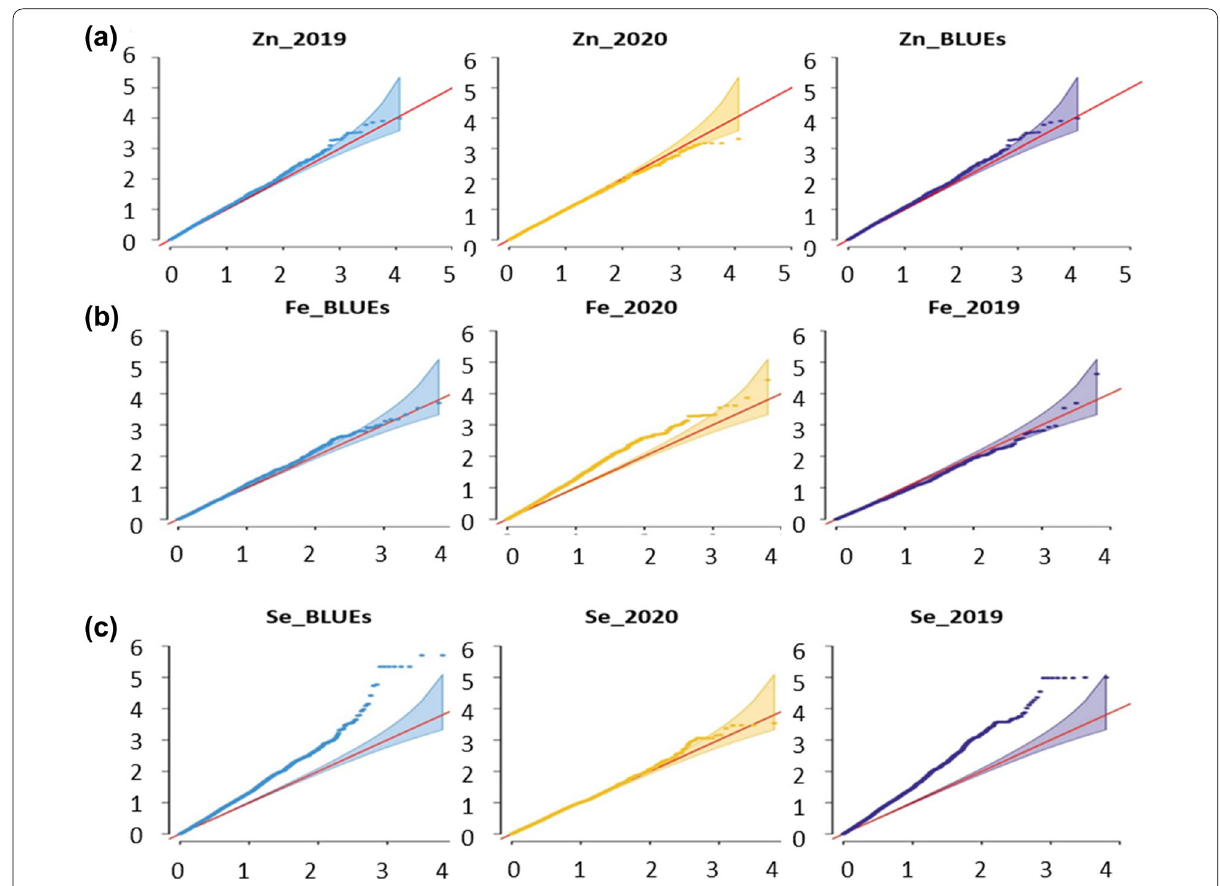
Fig. 7 Summary of quantile–quantile scale representing expected versus observed genotypes